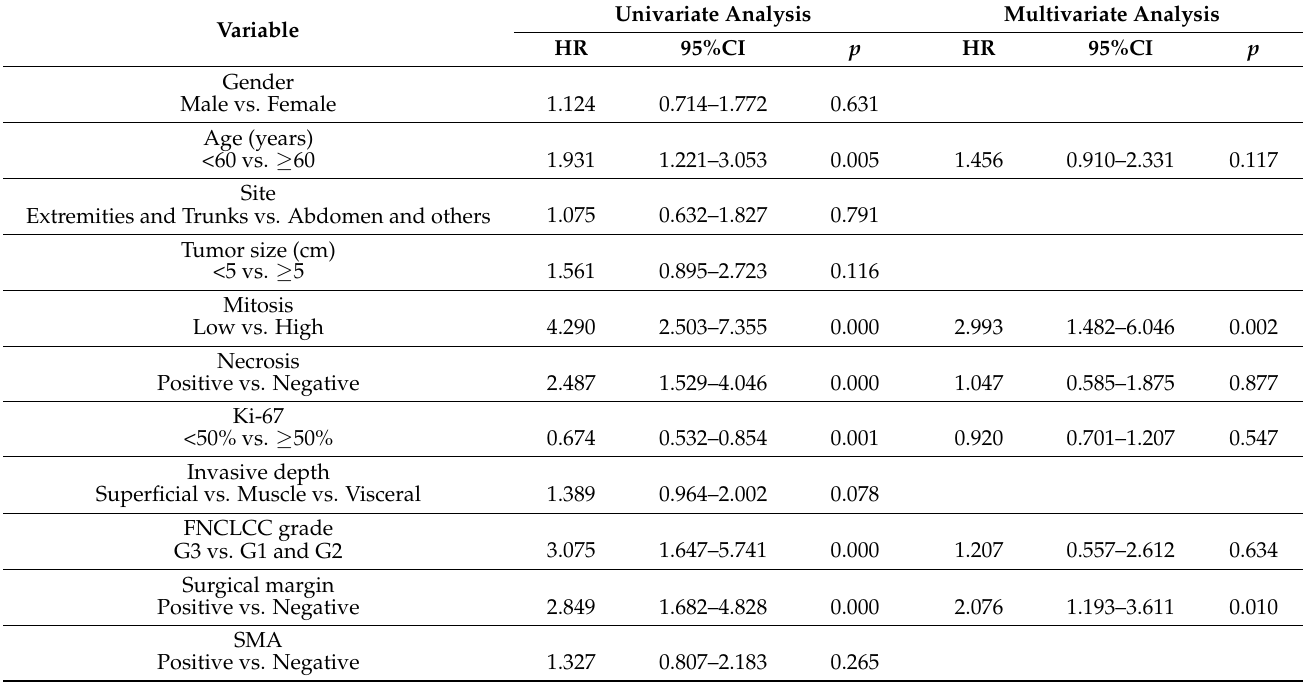
Table 3. Univariate and multivariate analyses of clinicopathological features and time to recurrence in UPS patients. Univariate Analysis Variable